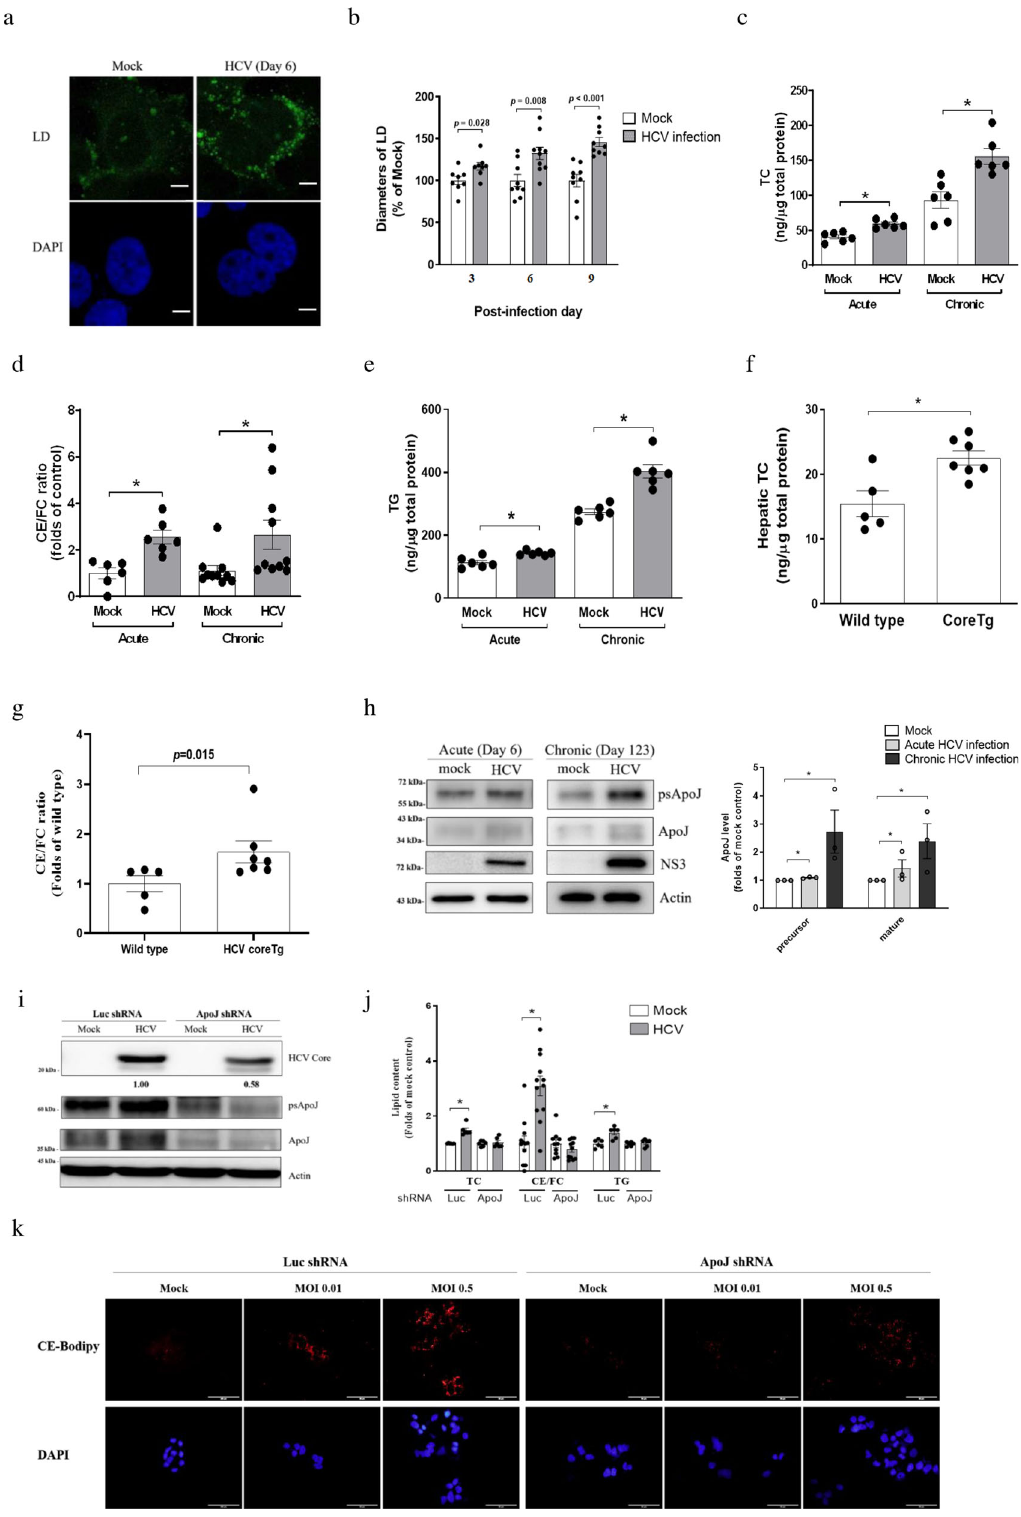
unaltered by HCV infection. HCV infections could induce Golgi (TGN38) dispersion from perinuclear to cytoplasmic sites (Fig. 2d, the left panel). In parallel, as shown by the increased co- localization coef fi cients ( p < 0.05) (Fig. 2d, the right panel), a signi fi cant portion of Golgi fragmentation occurred, thus leading to closer contacts with the SOAT2 than those in the mock